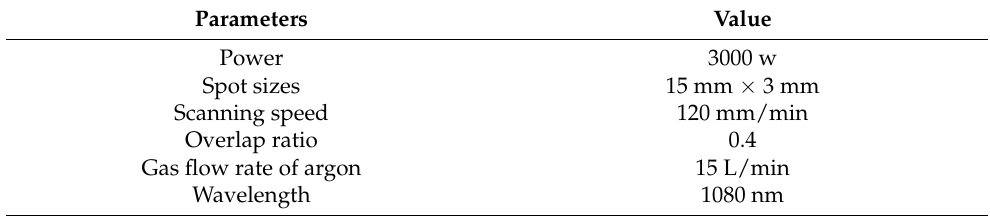
Table 1. Laser-cladding